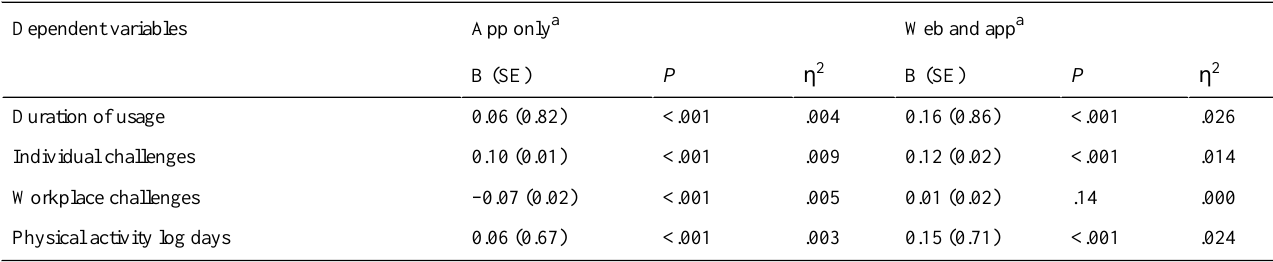
Table 3. Linear regression analyses showing associations between engagement parameters and app-only and Web-and-app groups in comparison to Web only in the overall sample (N=16,948).